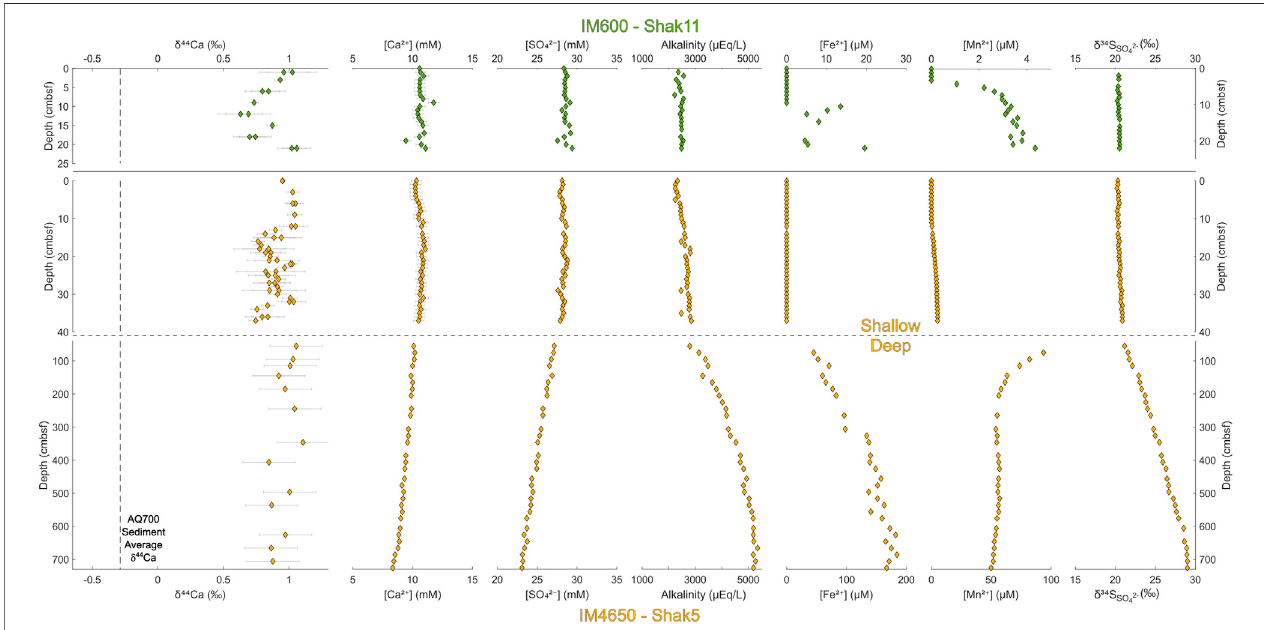
FIGURE2| Depth pro fi lesfortheIberian Margin sitesIM600and IM4650.ForIM4650,shallowercorestakenbymegacorer aredisplayedabovethedeeper pro fi le generatedbyapistoncore.Pore fl uidmajorionconcentrationsandisotopic compositions arerecordedrelative tosampledepthincmbelowthesea fl oor. N.B.Ironand manganese results have different axis scales at each site for ease of comparison.